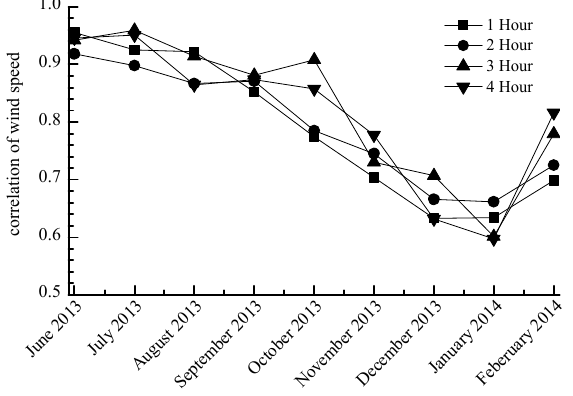
Figure 5. Statistical curve of WSC coefficient in different month.